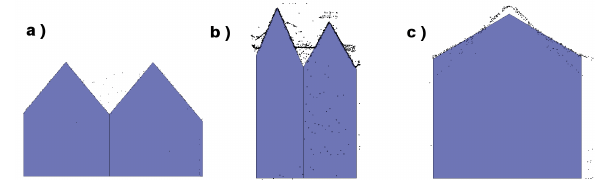
Figure 5. Roof models estimated with our approach based on an active sampling. The problems occurred by RANSAC (cf. figure 1) have been